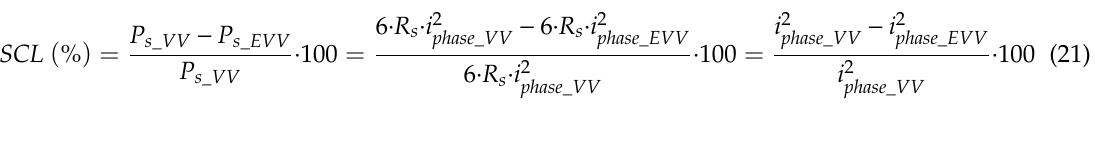
Table 3. Relative reduction of the RMS phase current value and stator copper losses (SCL) of the healthy phase currents for VV-MPC and EVV-MPC in test